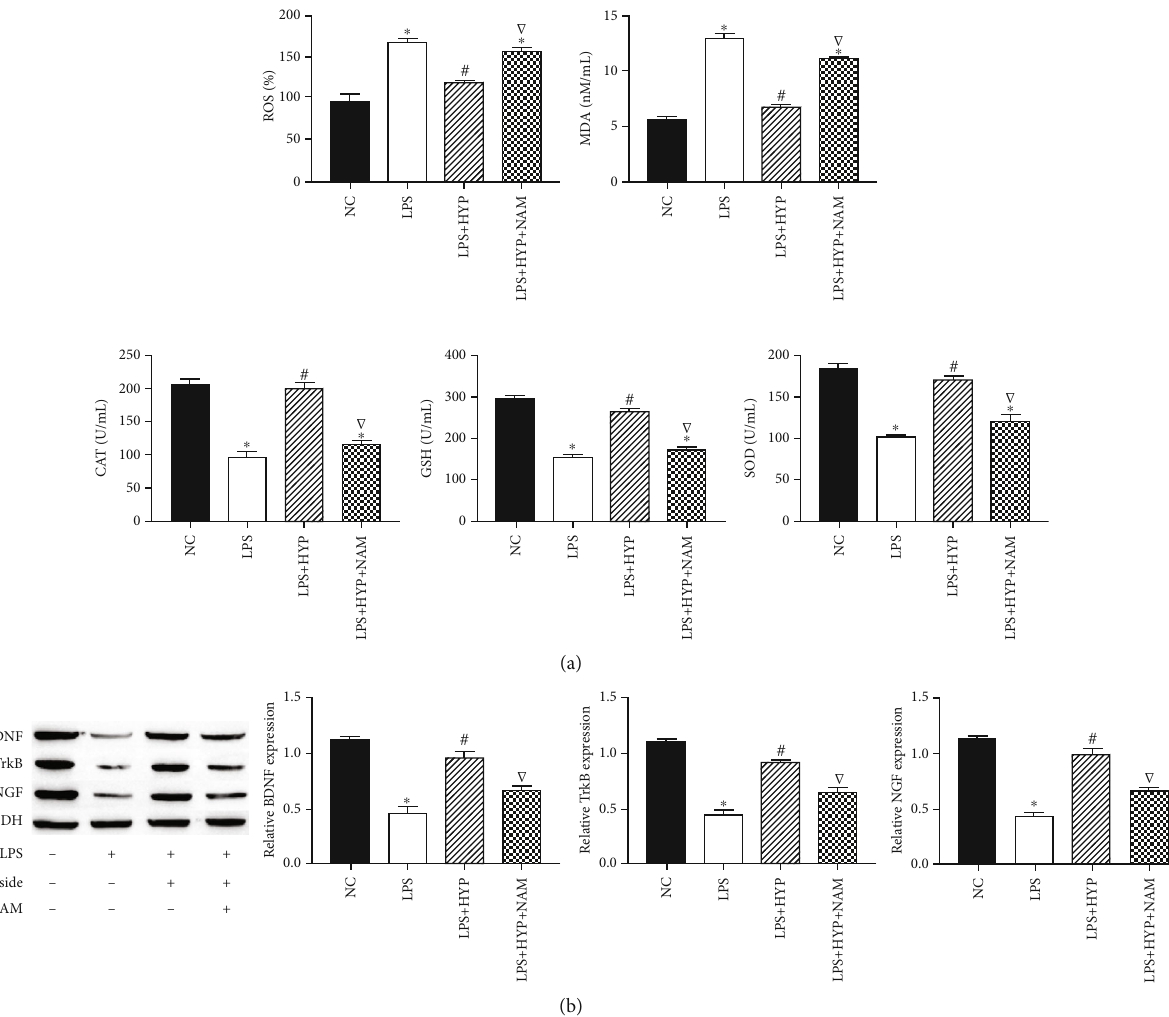
Figure 4: Hyperoside inhibits LPS-induced HT22 cell oxidative stress and reduction of neurotrophic factor through SIRT1. The level of SOD, GSH, CAT, ROS, and MDA were measured by corresponding assay kits (a). The expression of BDNF, TrkB, and NGF in HT22 cells was measured by western blotting (b). ∗ was considered signi fi cant compared to control ( ∗ P < 0 : 05 ); # was considered signi fi cant compared to LPS ( # P < 0 : 05 ); ▽ was considered signi fi cant compared to LPS+HYP ( ▽ P < 0 : 05